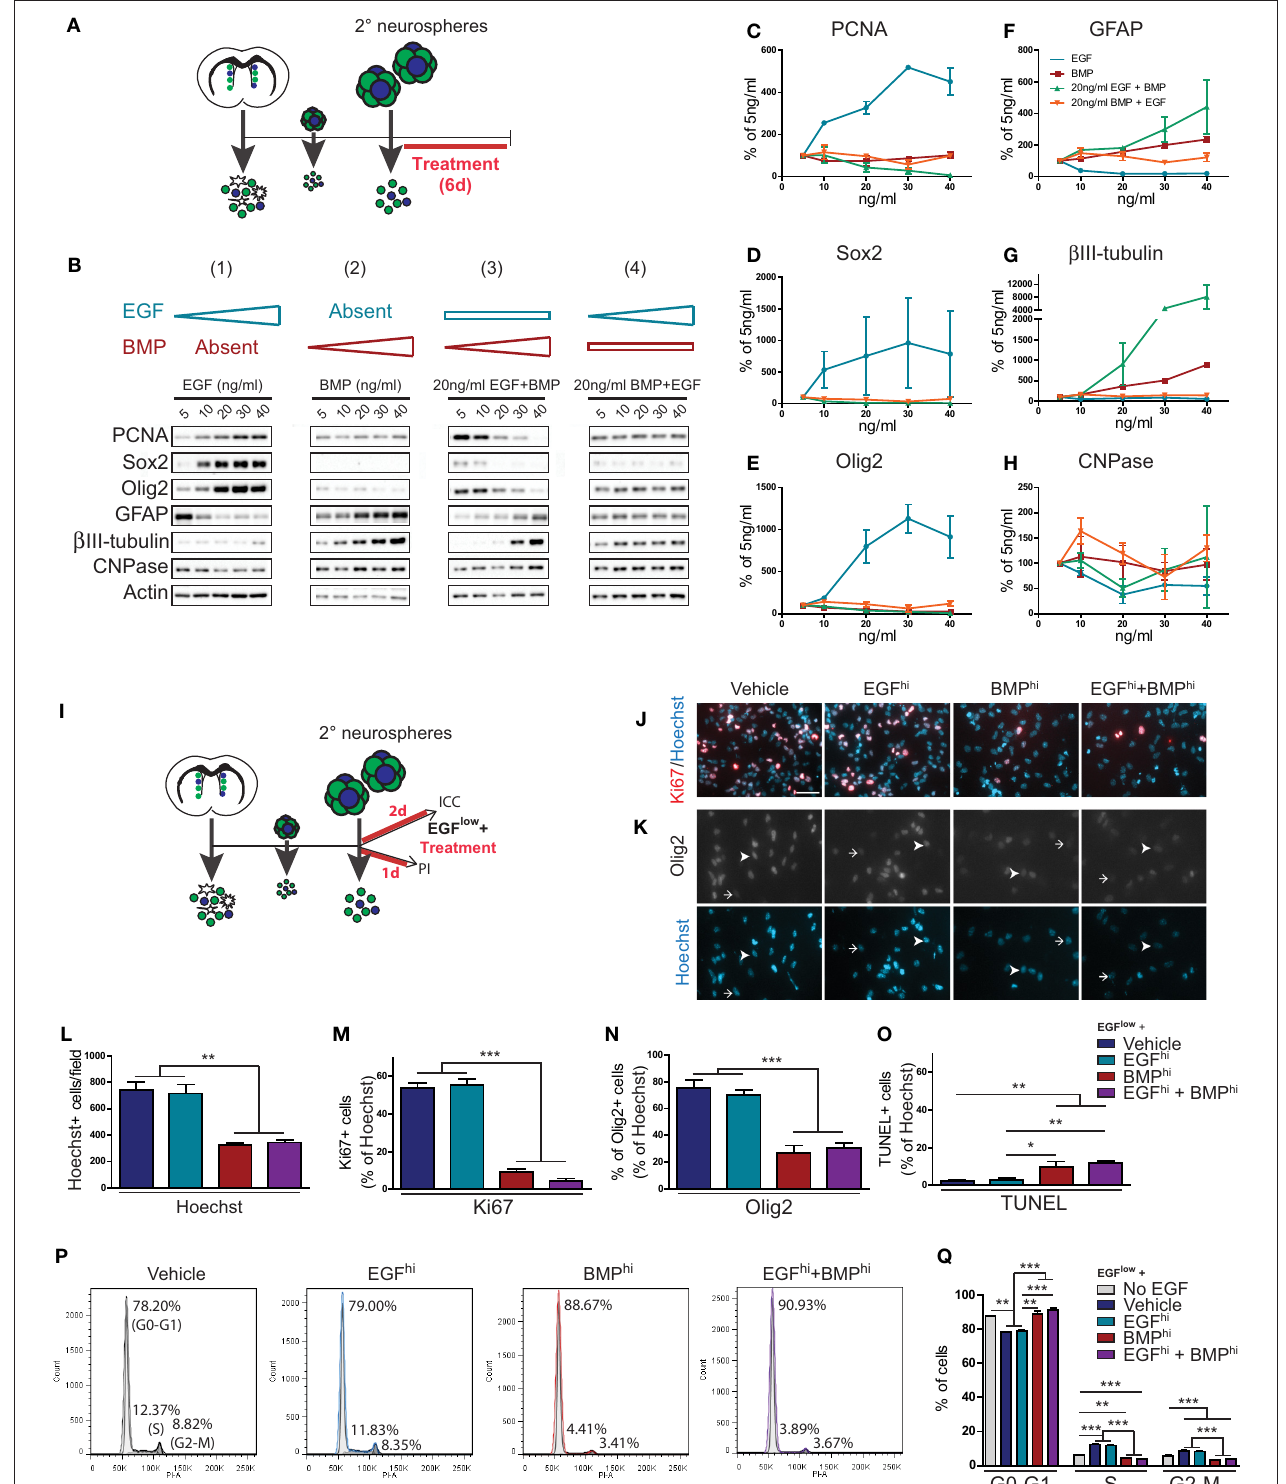
FIGURE 2 | BMP exerts dominant effects over TAP proliferation, differentiation, cell cycle parameters and cell death. (A–H) EGF and BMP dose-response experiments. Experimental paradigm (see Materials and Methods for details) (A) . Western blot analysis of cell lysates following dose-response